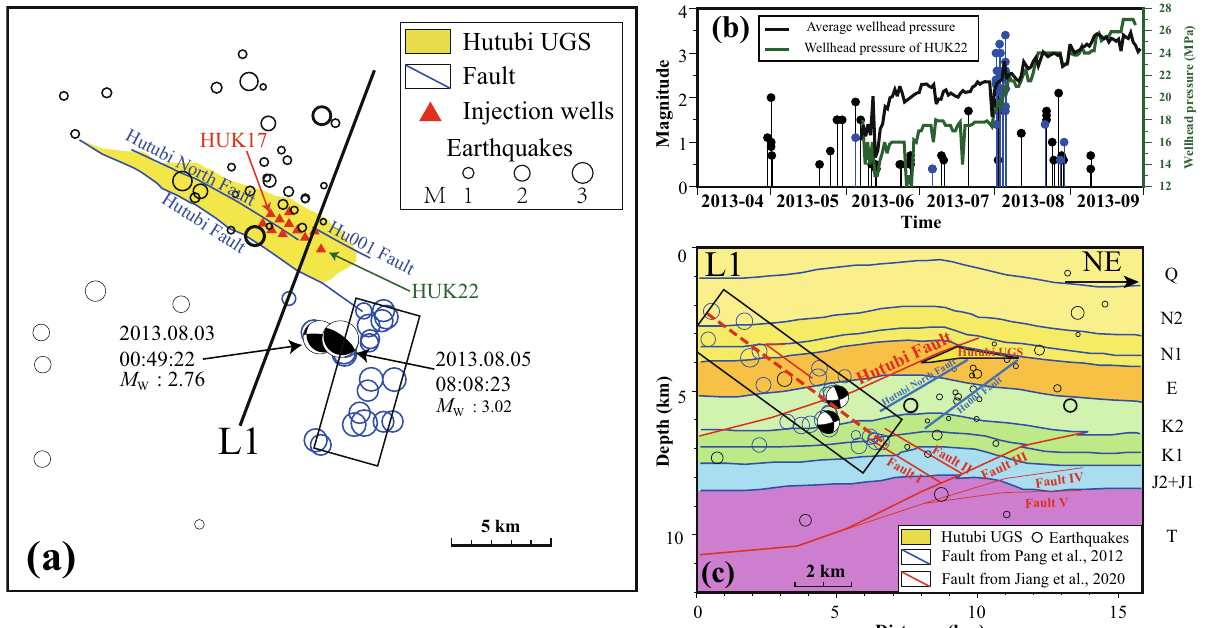
Figure 4. ( a ) The map view, ( b ) M–t diagram, and ( c ) profile along L1 in ( a ) of seismicity during the first injection period. Blue and black cycles are events belonging to clusters α and β, respectively. The average wellhead pressure and the wellhead pressure of HUK22 in ( a ) are shown in ( b ) as black curve and dark green curve, respectively. Beach balls in ( a ) and ( c ) correspond to the focal mechanisms of the two largest events from Zhou et al . 22 . The black box indicated the seismic zone formed by the cluster α. The solid red and blue lines in ( c ) are faults interpreted from the seismic reflection profile described by Jiang et al . 18 and faults inferred from seismic and geologic surveys 23,33 , respectively. The dashed red line depicts an extension of cluster